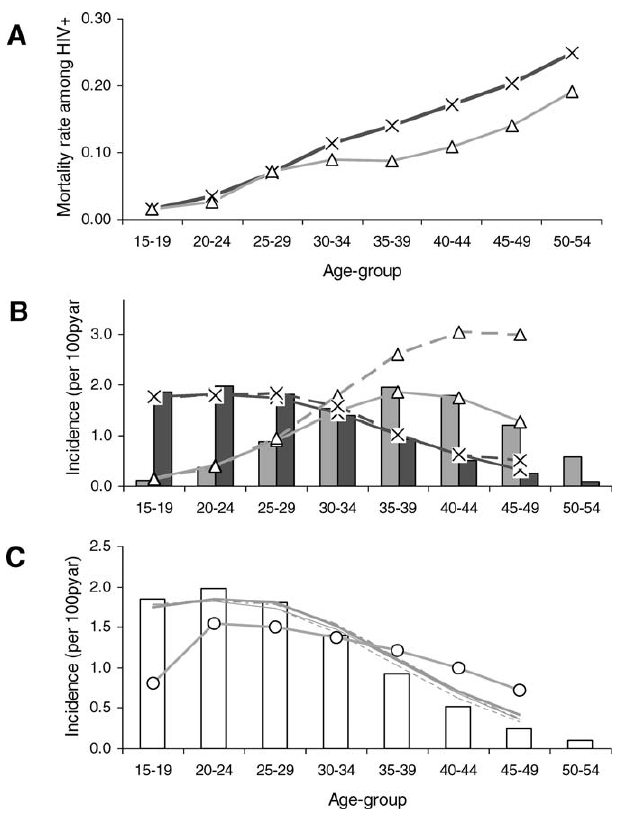
Figure 4. Comparison of Method Estimates With Simulated Data Under Range of Conditions Violating Underlying Method Assumptions. (A) The age-specific mortality rates for HIV-infected individuals when incidence is highest at young ages (dark line with crosses) or middle ages (grey line with triangles). (B) Estimates of incidence using method 1 when the ‘‘ wrong ’’ pattern age-specific mortality rates are used (i.e., from the alternative scenario in [A]: dashed lines) and when the correct rates or method 2 is used (solid lines). Bars show simulated incidence rates. (C) Estimates of incidence using method 2 when the age pattern of incidence changes (instantaneously between the two scenarios shown in [B]), 5 y (thick line), 10 y (dash-dot line), or 15 y (thin line) before the first survey. The dotted lines show the estimate if the age pattern of incidence does not change; the line with circles shows the estimates if the age pattern changes in the interval between the two surveys. The bars show the average incidence rate in the intersurvey period.